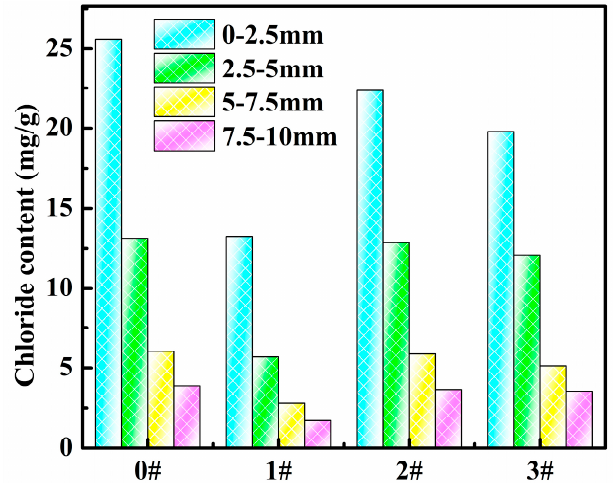
Figure 9. Mass fraction of chloride ions at different depths in mortar samples cured for 14 d (0 # : net slurry, 1 # : 1.06wt% PAMC-1+net slurry, 2 # : 1.06wt% PAMC-3+net slurry, 3 # : 1.06wt% PAMC-6+net slurry).